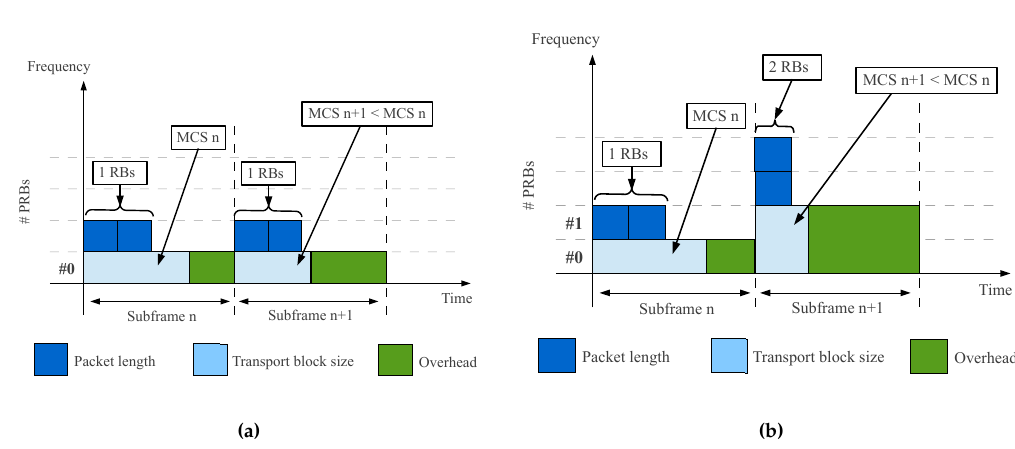
Figure 2. Energy efficient IoT data collection uploading solution. The overhead refers to the link layer ( i.e. , L2) and varies according to the LTE Modulation and Coding Scheme adopted to guarantee a BLER of 10%. ( a ) Fixed number of RBs; ( b ) Variable number of